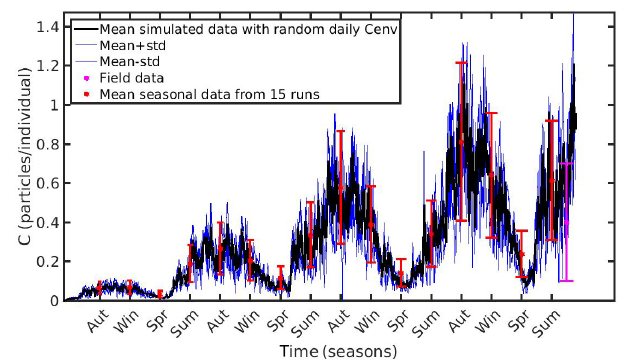
Figure 9. Mean seasonally values and standard deviation of mi- croplastics (MPs) accumulation (red error bars: mean value ± SD) by the mussel in North Sea derived from 15 model runs with dif- ferent constant values of environmental MPs concentration ( C env range: 0.1–0.8particlesL − 1 ); Mean hourly simulated data (black line) and standard deviation (blue lines) of microplastics accumu- lation derived from three model runs with stochastic sequences of daily random C env values.